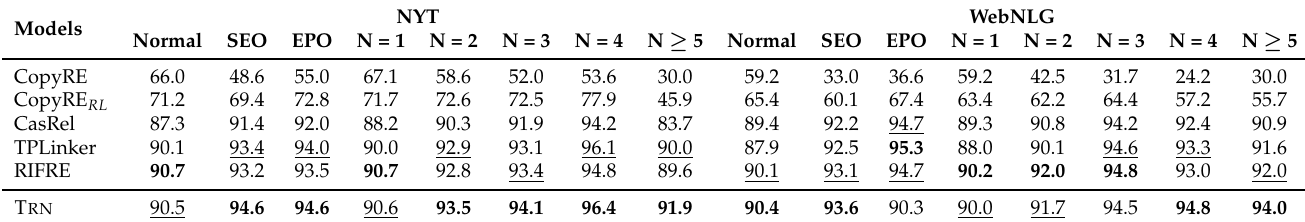
Table 3. The F1-sores on sentences with different numbers of triples. N is the number of triples in a sentence. The best scores are in bold, while the second-best scores are